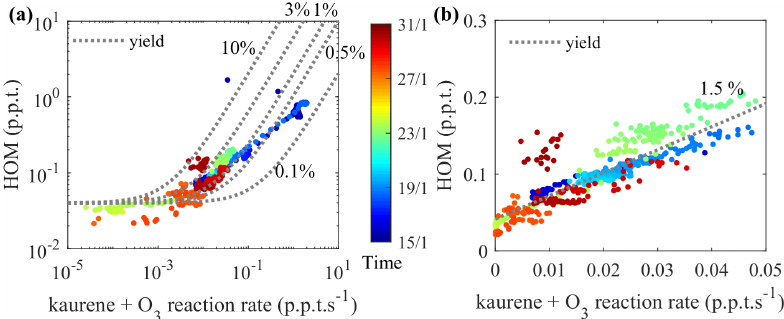
Figure 5. HOM yield estimation; HOM concentrations were plotted against the kaurene ozonolysis rate in (a) and (b) . Markers are colored by time, representing the changes of calibration factors applied to kaurene signals. Lines are added to the plots to represent constant HOM molar yields from kaurene ozonolysis, accounting for an instrumental HOM background in the CI-APi-TOF of 0.04ppt. (a) All data points (plotted in logarithmic scale) from the periods without seed particles in the chamber. A zoomed-in view of (a) with reaction rates ranging from 0 to 0.05ppts − 1 is shown in (b) (plotted in linear scale).